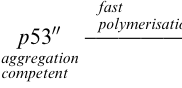
Figure 1. ITDF results. A: A typical denaturation curve. Initially ( t =0) well-folded proteins (squares, blue) and fluorescent dye (star, light red) are mixed, and the fluorescence is low. Over time the protein denatures (undefined shape, blue) and its exposed hydrophobic core binds to the dye (stars, bright red), leading to a fluorescence increase which is monitored. B: Examples of Arrhenius plots for Mmp53 of the unfolding of the quaternary structure ( k 1 , circles) and the core domain ( k 2 ,